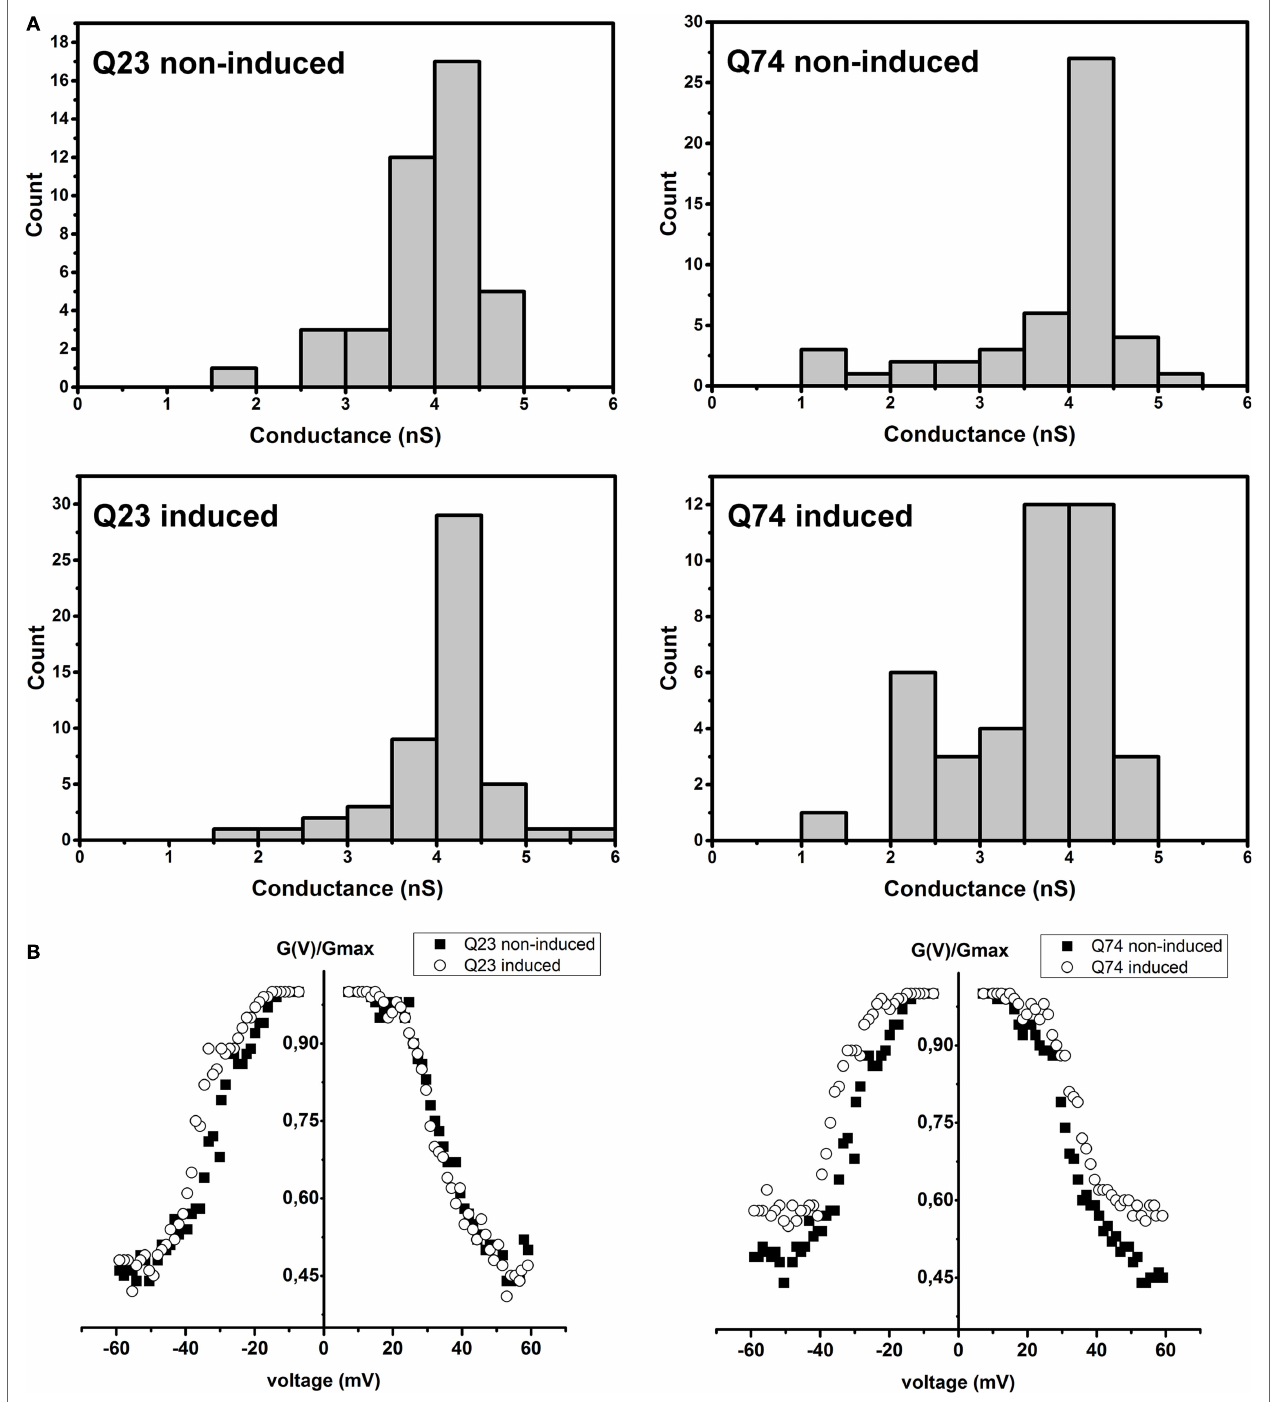
FigUre 4 | The effect of htt and mhtt expression on reconstituted VDac preparations isolated from Pc12 hD-Q23 and Pc12 hD-Q74 cells, respectively, after the expression lasted for 48 h . (a) Histograms of conductances calculated at a membrane potential of + 10 mV. The data reflect the following number of insertion events: Q23 non-induced, 41; Q23 induced, 52; Q74 non-induced, 41, and Q74 induced, 49 (B) The voltage-dependence assessed due to current measurements by triangular voltage waves. G max denotes average conductance values calculated in the presence of the lowest applied potential. The average amount of the analyzed insertions for a given potential value and VDAC preparation was 45 for 2–3 different preparations of VDAC proteins. Q23 non-induced and Q74 non-induced denote PC12 HD-Q23 and PC12 HD-Q74 cells cultured for 48 h without expression of Htt and mHtt, respectively, whereas Q23 induced and Q74 induced denote the cells with the proper expression lasted for 48